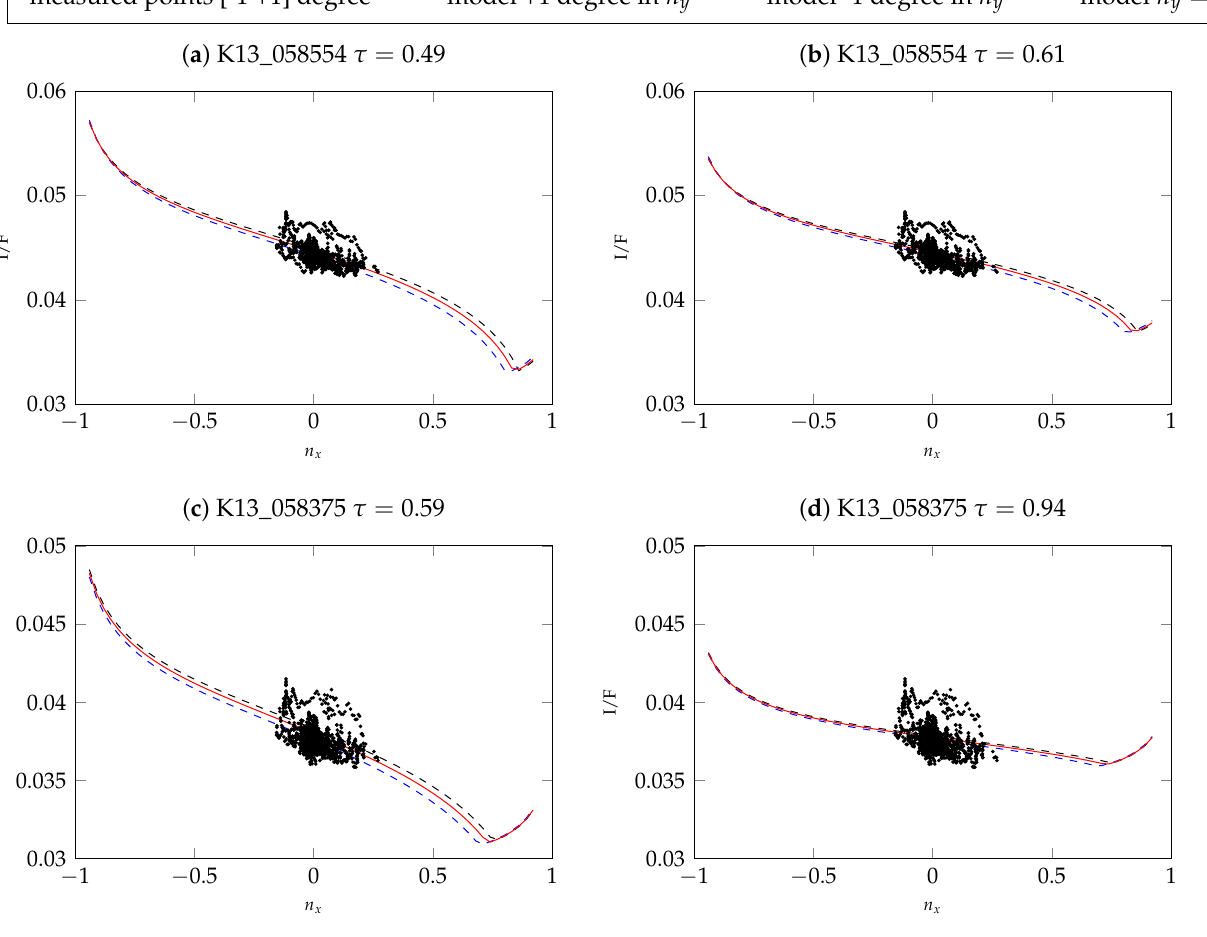
Figure 7. 2D representations of the atmospheric model for the different parameters for the images K13_058554_2232_XN_43N103W and K13_058475_2232_XN_43N103W. The plots correspond to the planar intersection of the 3D representation (similar to Figure 6) and are created by omitting all points with a normal vector inclination of above 1° and below 1° in y-direction. The red line represents the − model for n y =